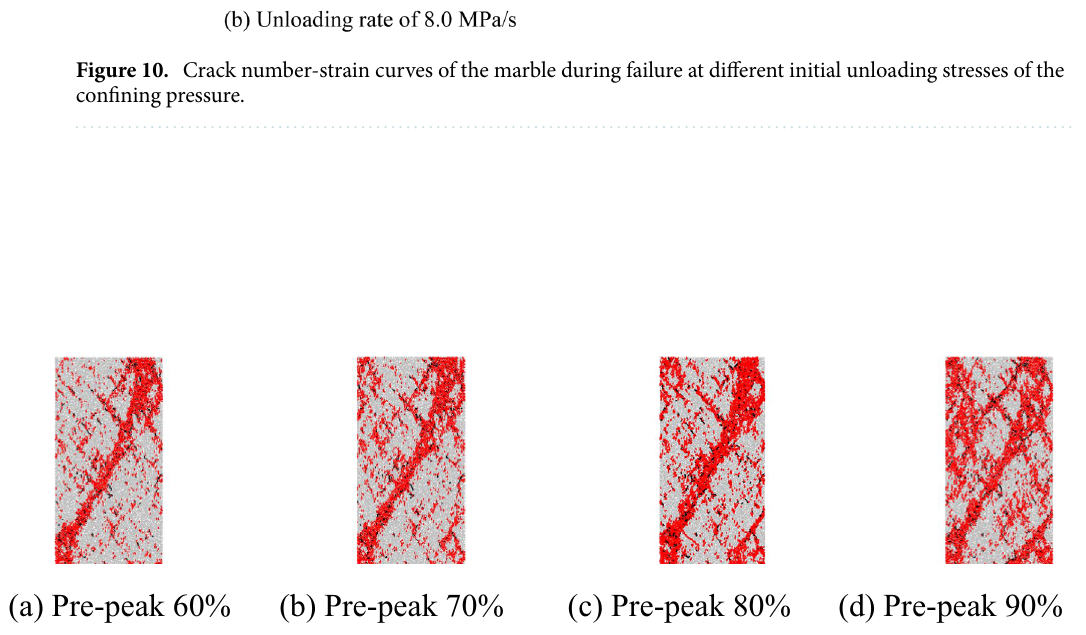
Figure 11. Failure modes of the marble at different initial unloading